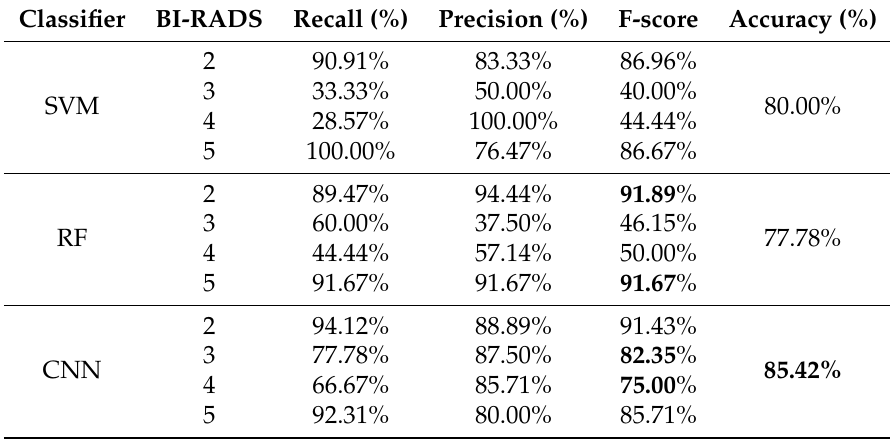
Table 9. A comparison of the performances of different machine learning